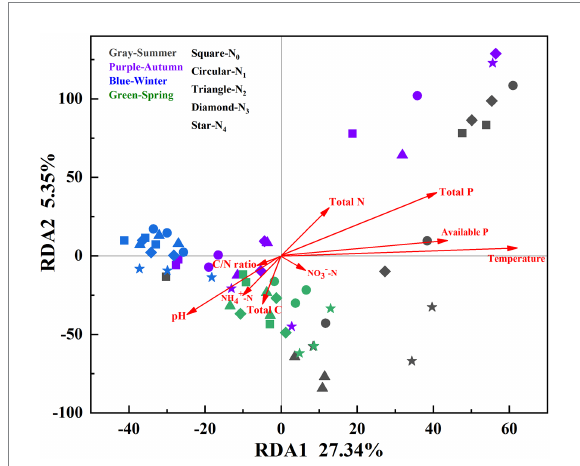
FIGURE 4 RDA for soil AM fungal community compositions (based on the species level) and environmental factors in the poplar plantations under different nitrogen additions in four seasons. N 0 , N 1 , N 2 , N 3 , and N 4 were 0, 5, 10, 15, and 30 gN·m − 2 ·a − 1 ,